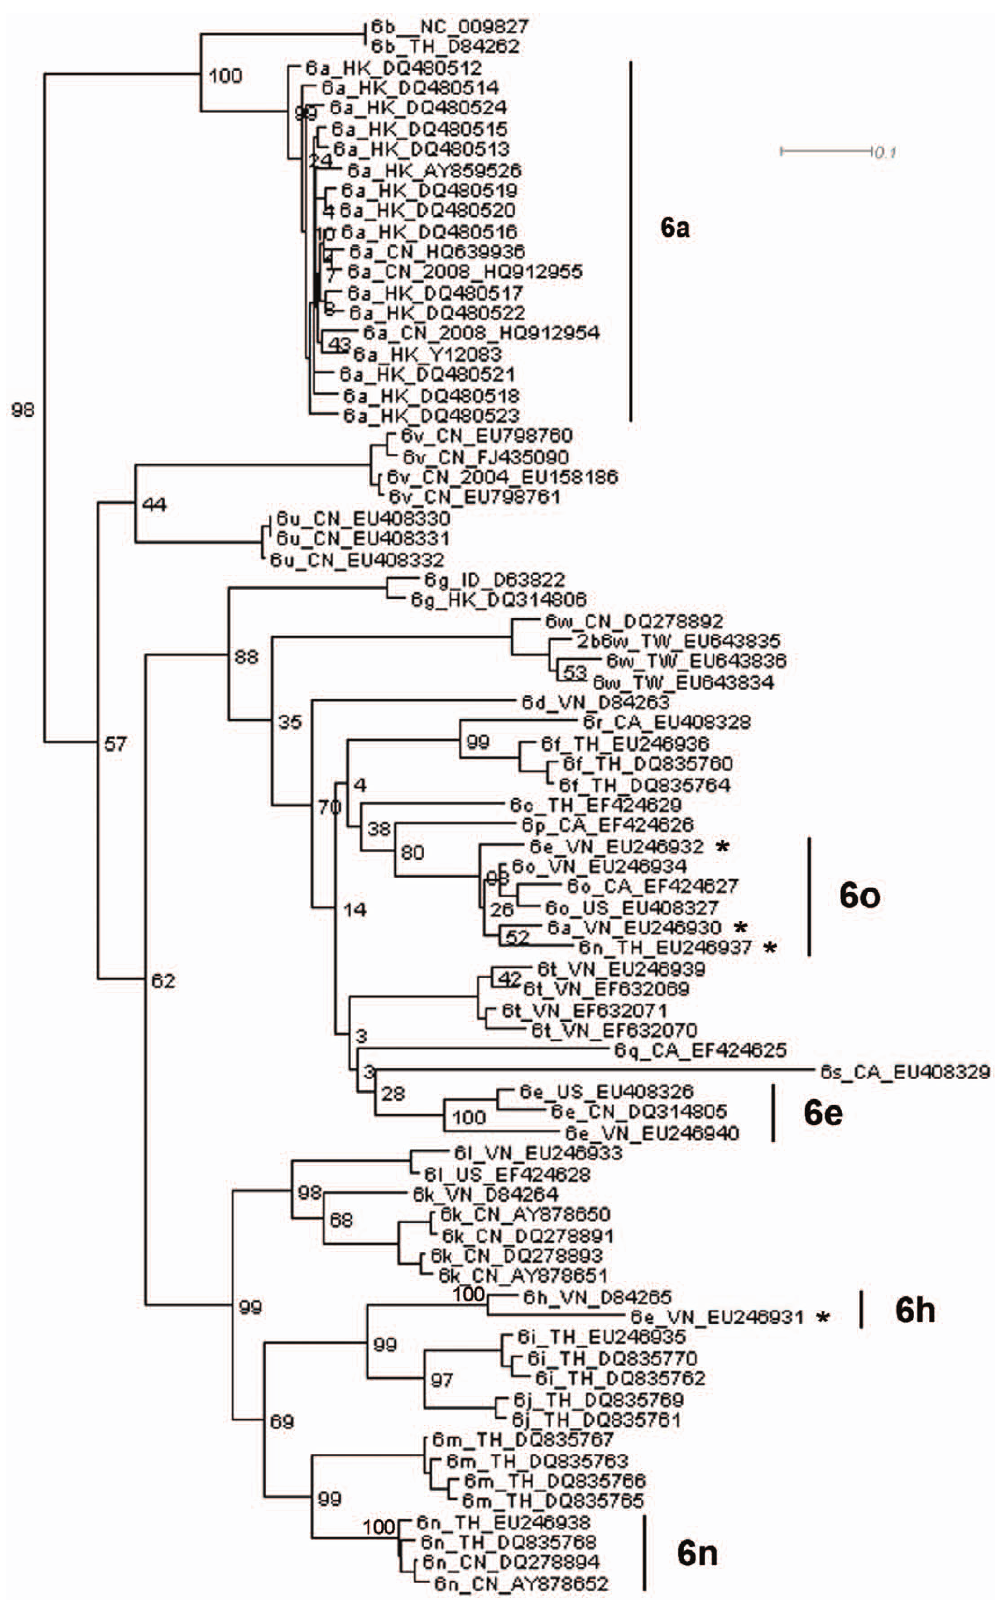
Figure 2. The genotype 6 part of the phylogenetic tree constructed using the last 827 bp of the alignment.